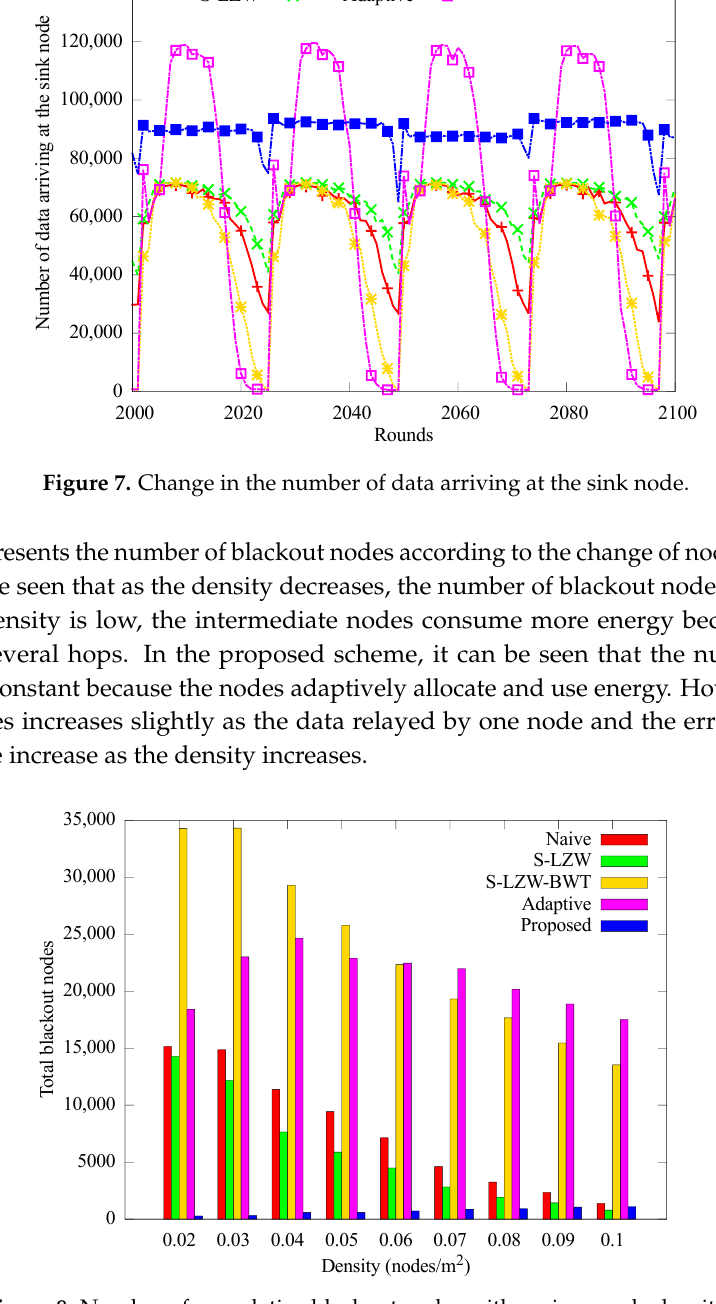
Figure 8. Number of cumulative blackout nodes with various node